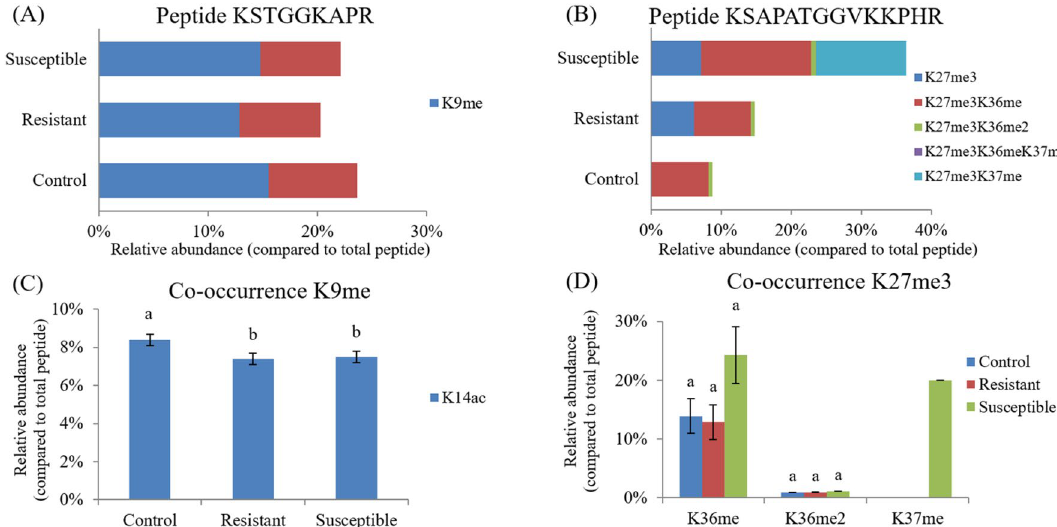
Figure 7. H3K9me and H3K27me3 with distinctive crosstalks that have highly specific histone codes in the adrenal gland of different groups of male L2 strain TCCs. The relative abundance of peptides containing H3K9me and H3K27me3 is depicted in Panels ( A ) and ( B ), respectively, and the relative abundance of PTMs co-expressed with H3K9me and H3K27me3 are shown in Panels ( C ) and ( D ), respectively. Results in Panel ( C ) and ( D ) are expressed as mean ± standard error (n = 5) without missing values. a,b Superscripts indicate a difference between groups within the same PTMs ( P <